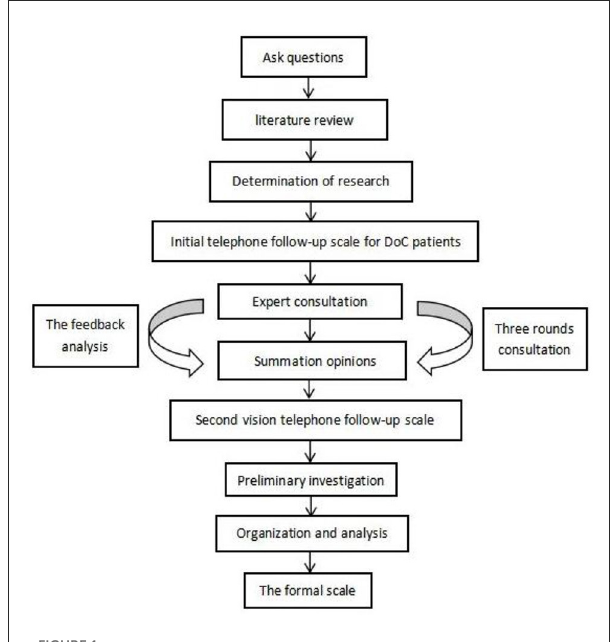
FIGURE1 Flow chart of scale development.